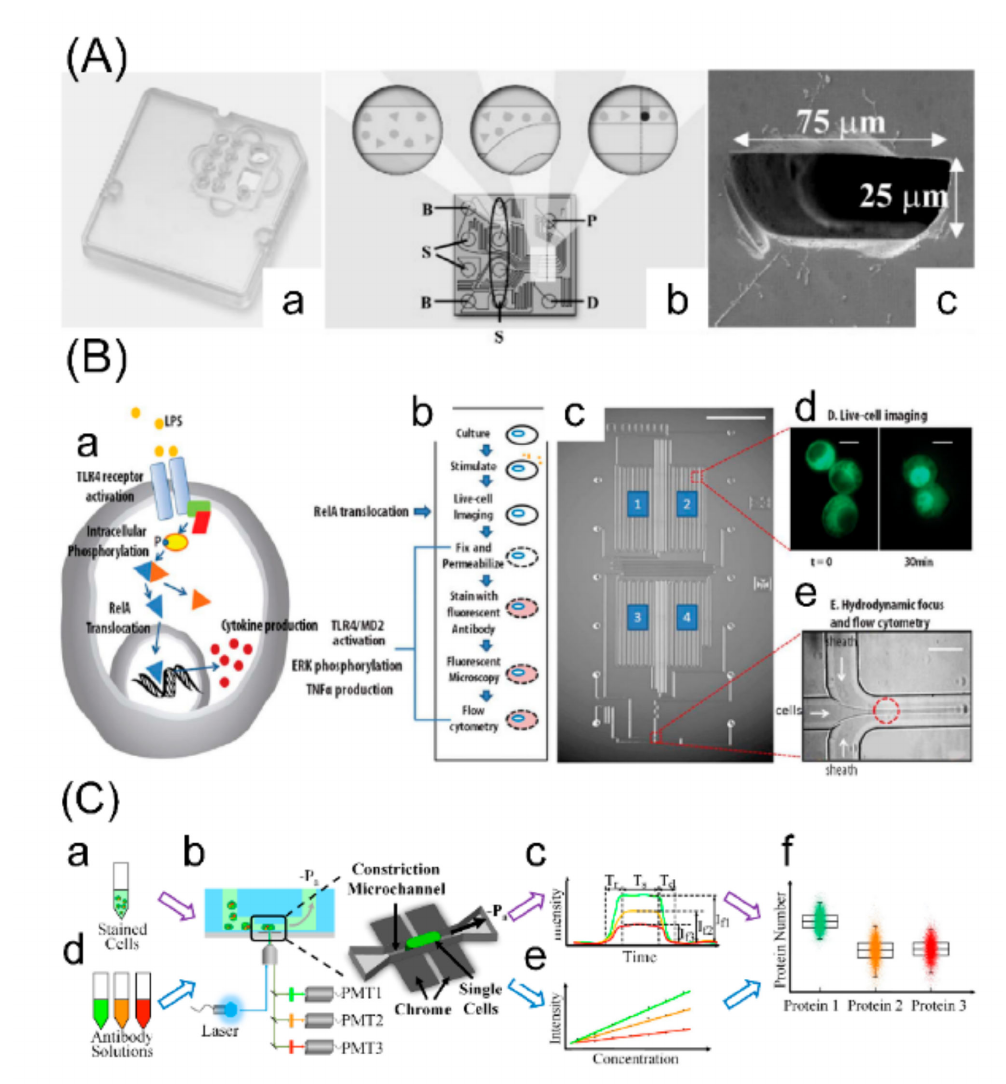
Figure 2. Microfluidic flow cytometry for single-cell protein analysis. ( A ) A commercially available microfluidic flow cytometry for analysis of protein expression with a small number down to 625 cells per sample. (a) Schematic of the microfluidic chip; (b) layout of the microfluidic glass chip with sample wells (S), bu ff er wells (B), the well for the reference dye (D), and the priming well (P); (c) cross-section micrograph of a channel with dimensions of 25 × 75 µ m after bonding top and glass plate. Adapted with permission from [68]. ( B ) A microfluidic chip for global profiling of cellular pathways. (a) TLR4 signaling events occur at di ff erent timescales and subcellular locations; (b) shows the workflow procedures integrated and performed on the chip shown in (c); all the representative events in the cell diagram can be profiled using both fluorescent microscopy (d) and flow cytometry (e). Adapted with permission from [69]. ( C ) An improved microflow cytometry platform based on a constriction channel for absolute quantification of multiple intracellular proteins. Cells stained with multiple fluorescent labelled antibodies (a) are aspirated into the constriction microchannel with excited fluorescent signals detected by photomultiplier tubes (b); for each travelling cell, time coordinated fluorescent pulses are obtained with fluorescent levels (c); the calibration curves are obtained by the gradient solutions of multiple types of fluorescent labelled antibodies (d,e); based on raw parameters and calibration curves, numbers of multiple types of intracellular proteins are obtained (f). Adapted with permission from